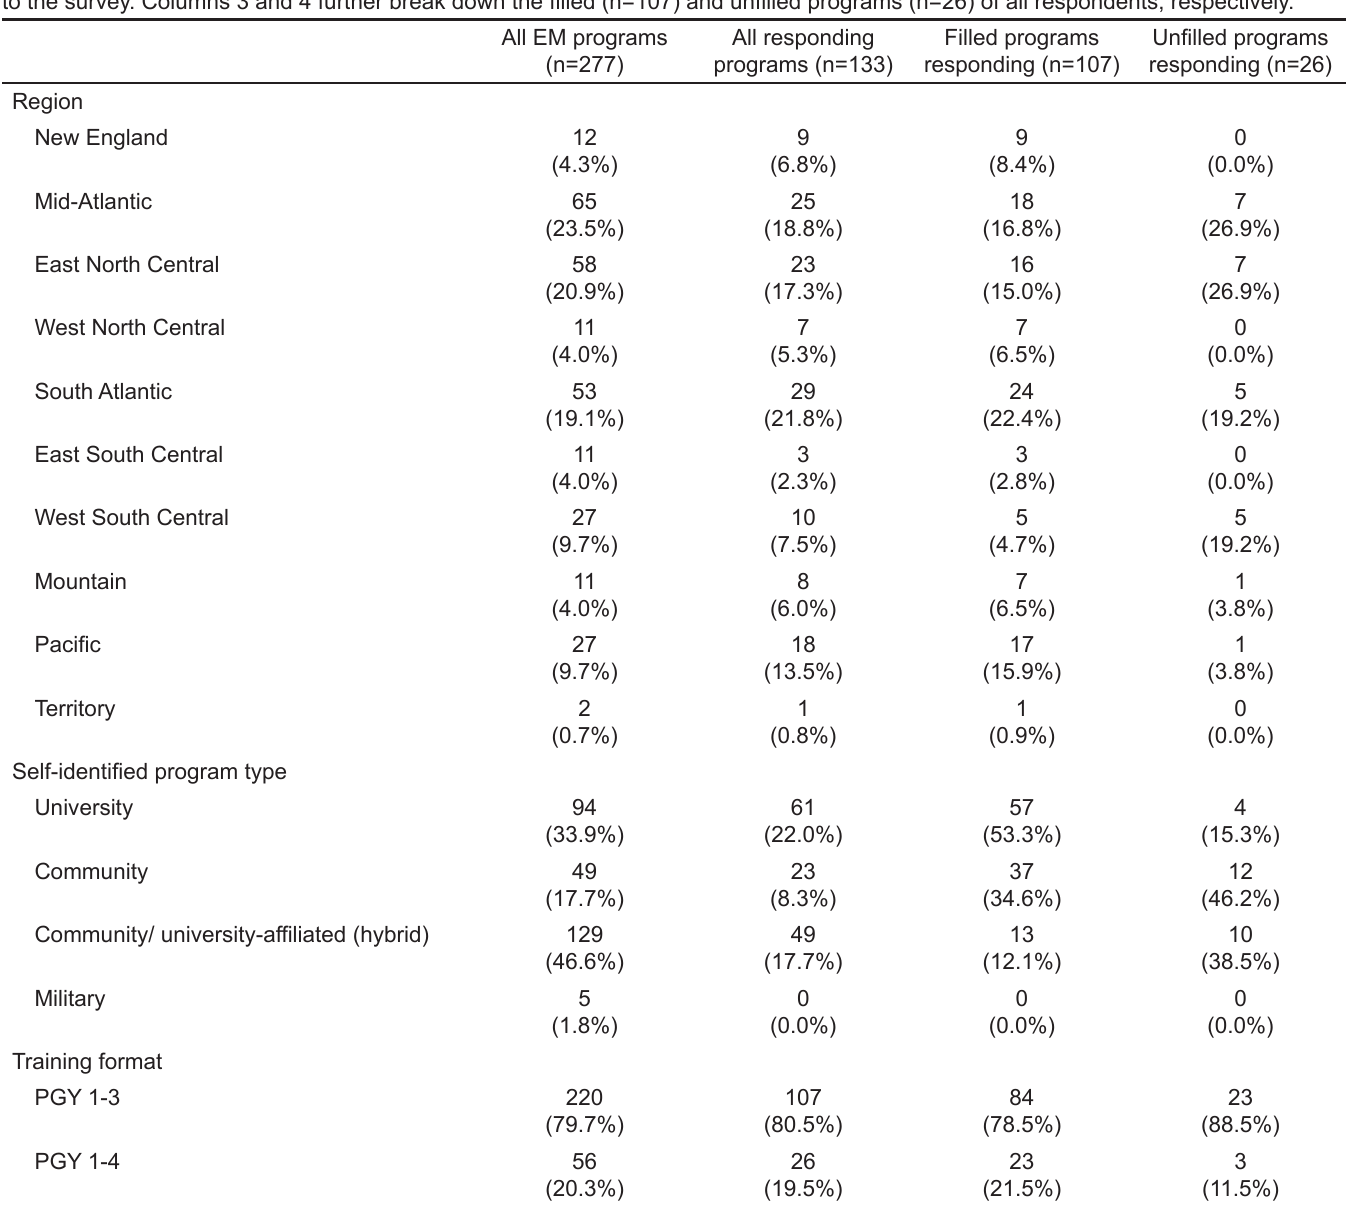
Table 1. Emergency medicine (EM) program demographics. Column 1 (All EM programs) represents the complete list/description of ACGME-accredited EM programs. Column 2 (All responding programs; n=133) indicates the total number of programs that responded to the survey. Columns 3 and 4 further break down the filled (n=107) and unfilled programs (n=26) of all respondents,